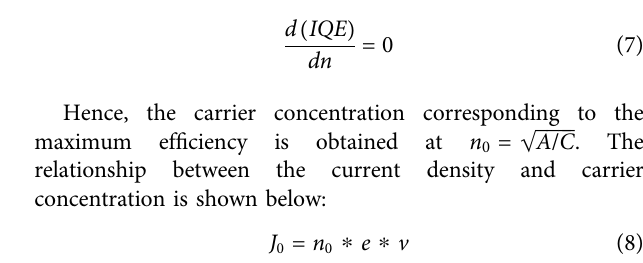
Frontiers in Physics |